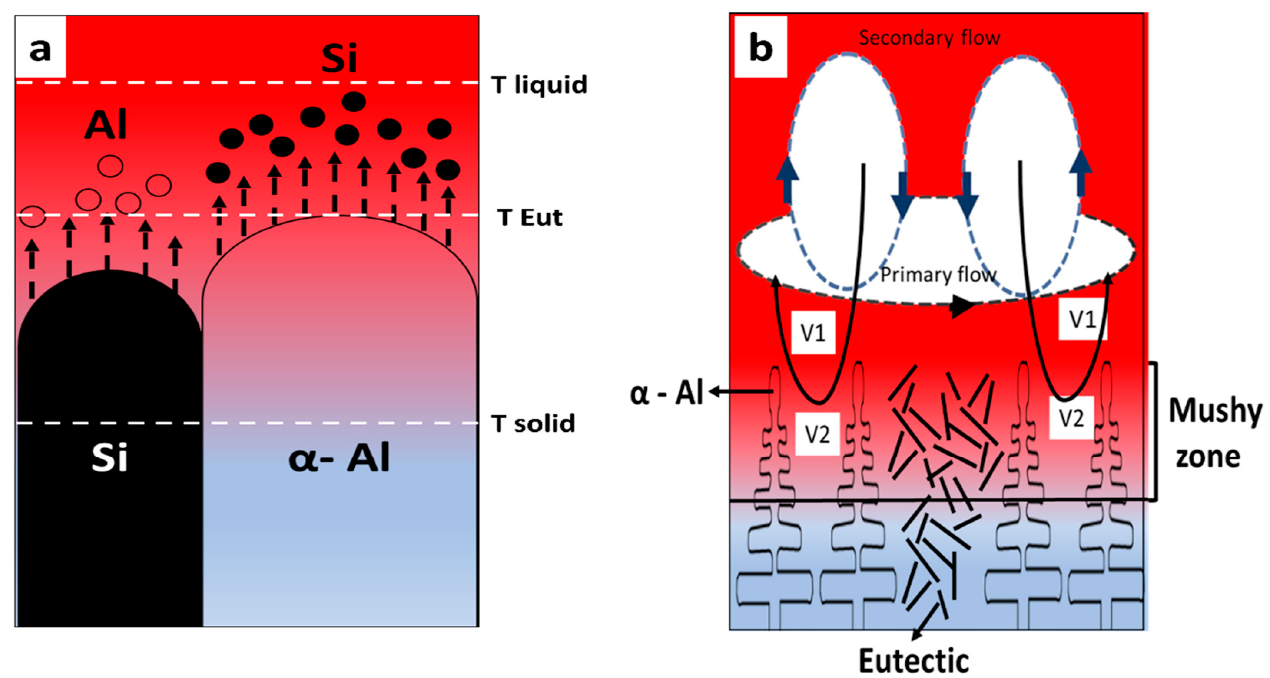
Figure 10. Solidification mechanism with and without the presence of RMF, ( a ) Eutectic composition alloy without RMF, ( b ) Eutectic alloys with RMF.